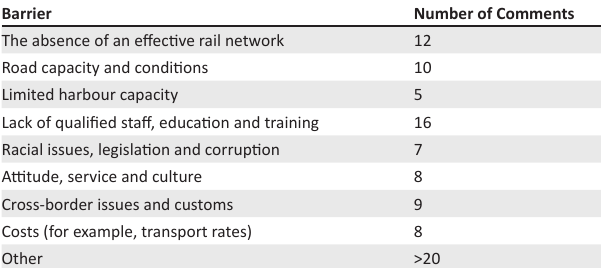
TABLE 2: Stakeholder view of the barriers and issues affecting